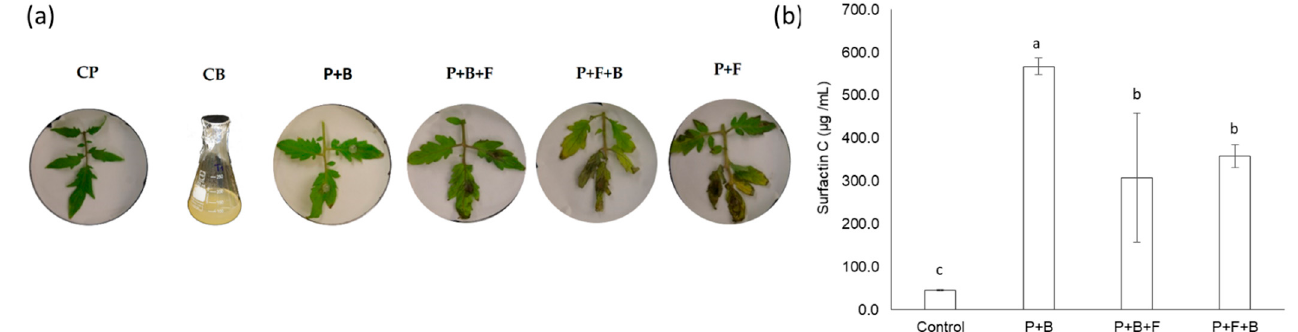
Figure 2. Effect of tomato root– Bacillus interaction on B. cinerea infection and surfactin C production. ( a ) Phenotype of representative leaflets per treatment infected with B. cinerea . ( b ) Adjusted surfactin C production in the four bacterial treatments normalized by the log of the colony-forming units (cfu) per milliliter of medium (cfu/mL) at 24 h. Different letters above the bars represent significant differences between the treatments according to the Tukey test ( p < 0.05); n = 3 (three pooled replicates from three individuals each).